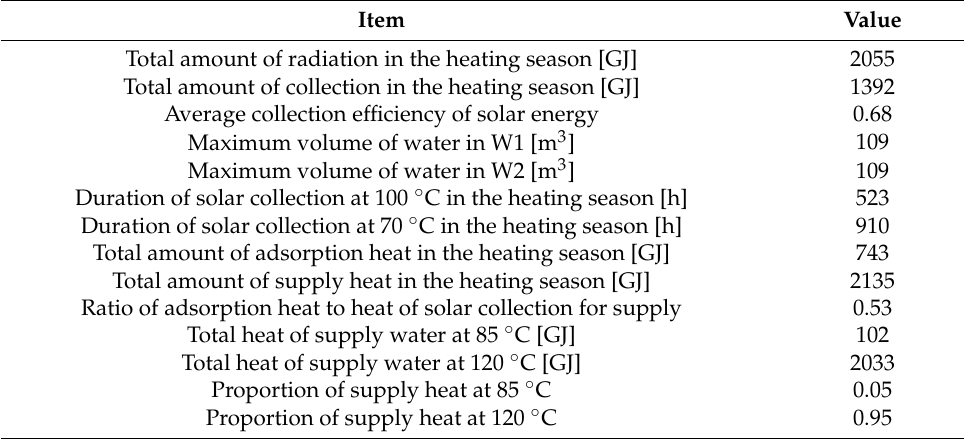
Table 5. Simulation results for the heating